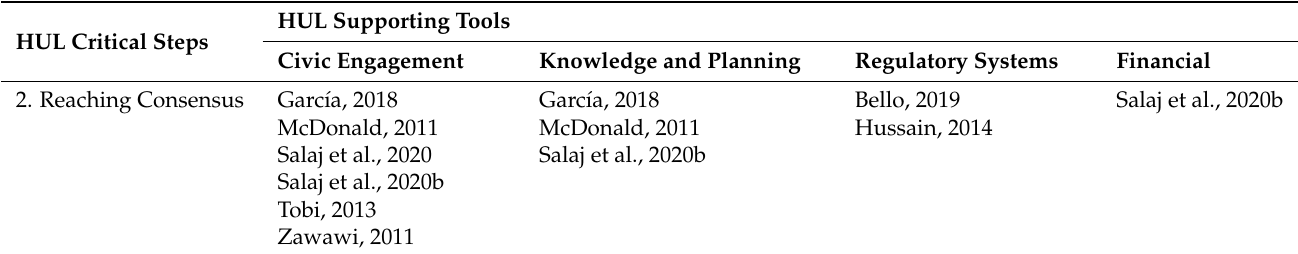
Table 2. List of authors discussing the reaching-consensus supporting tools of the HUL approach within the urban heritage facility management